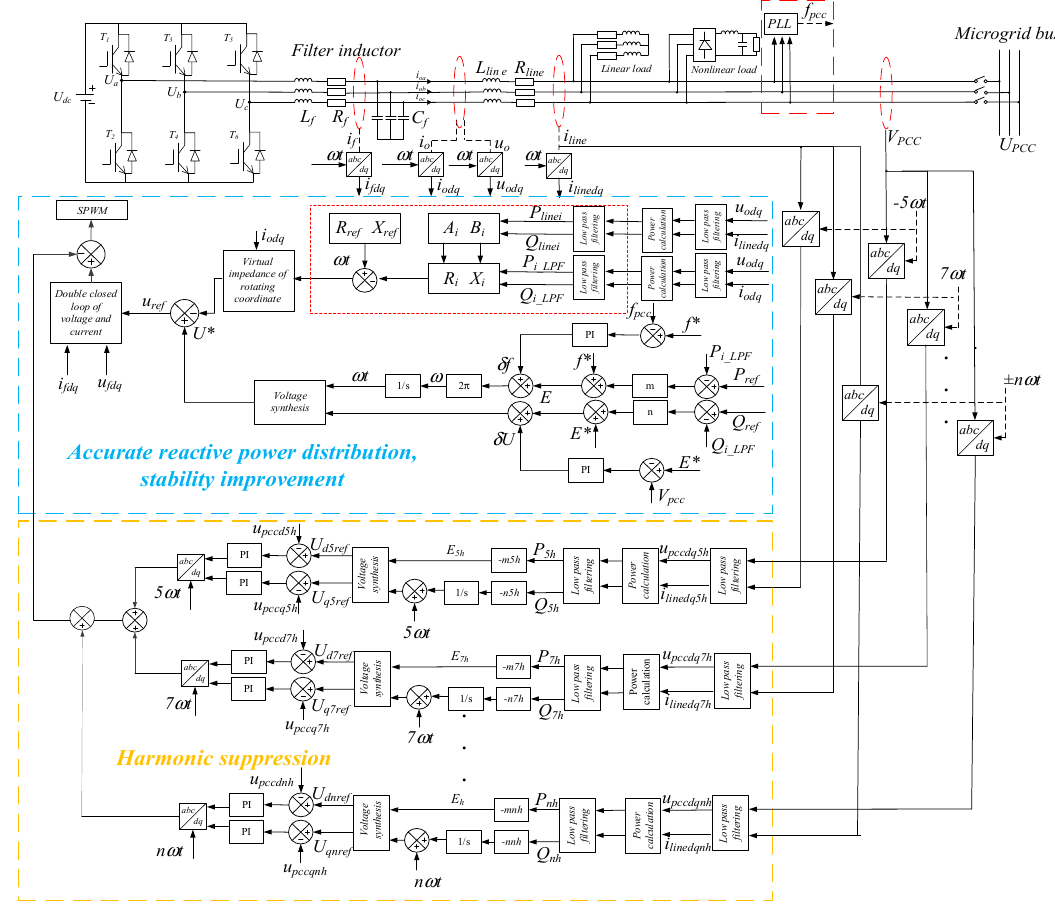
Figure 1. Block diagram of comprehensive control strategy.